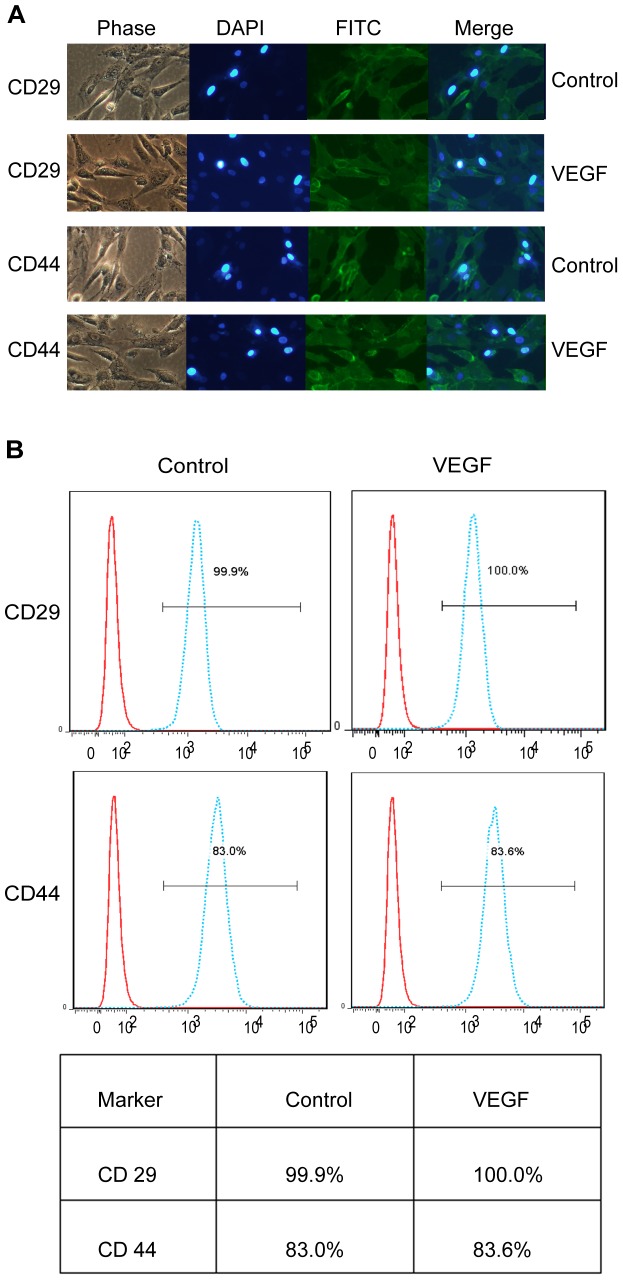
The maintenance of multipotent cell surface markers in ADSCs.(A) CD29 and CD44 staining revealed that cells had a similar pattern of expression compared to the untreated group after VEGF treatment; (B) Flow cytometry indicated that ADSC surface markers (CD29 and CD44) showed similar abundance compared with the untreated group.